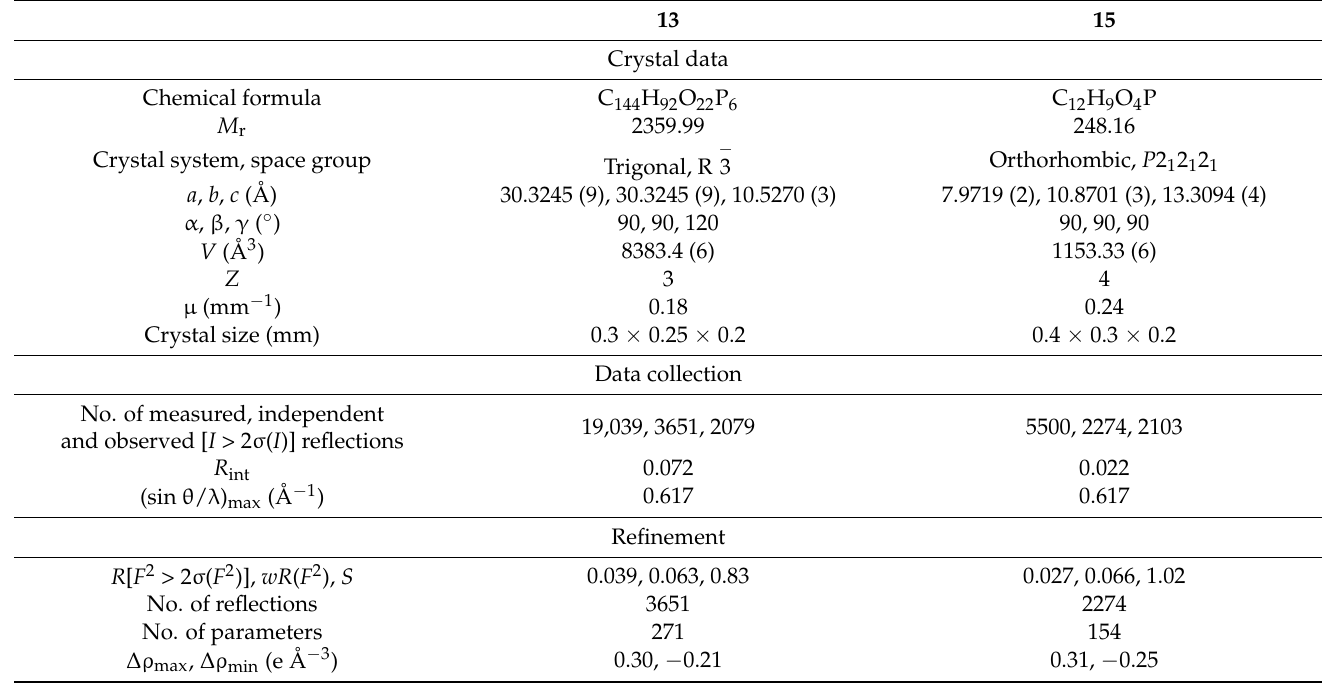
Table 1. X-ray crystallography experimental